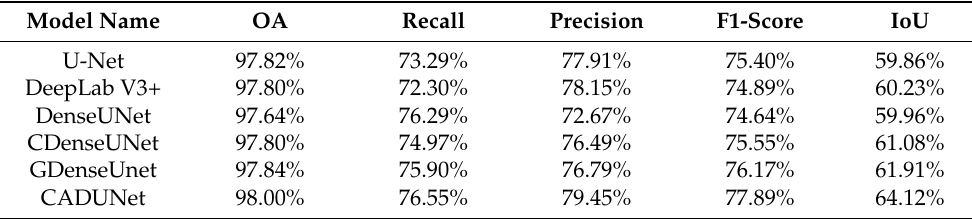
Table 1. Accuracy assessment of the road extracting results obtained by six methods in the Mas- sachusetts dataset.